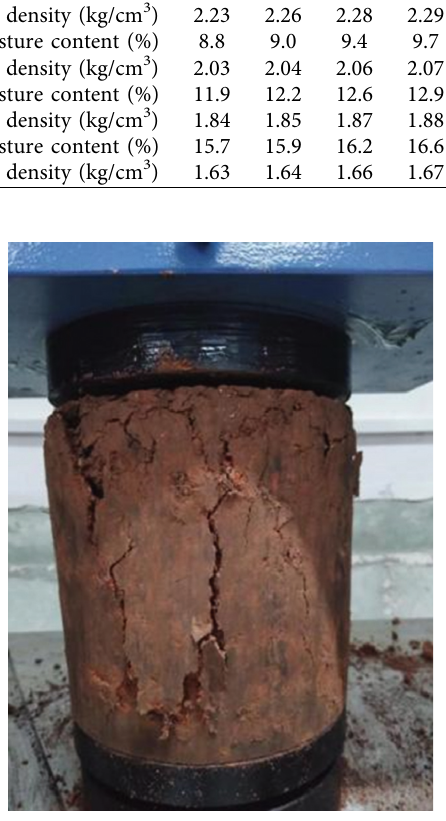
Figure 10: Compression strength test.